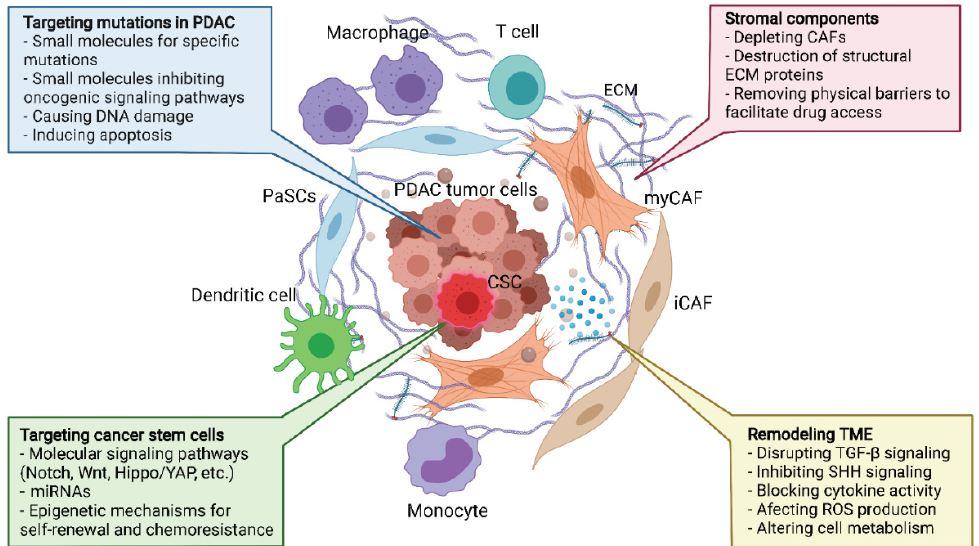
Figure 2. Neoplastic cells and ECM targeting approaches in PDAC treatment. Because of its large contribution to tumor development and treatment resistance, the heterogeneity of tumor cells, mutations, and ECM of PDAC are also attractive targets for therapeutic development. Targeting the KRAS protein and its upstream and downstream signaling are some of the most potential targets for drug development and are under investigation in several trials. Besides that, the therapeutic approaches for eliminating cancer stem cells in PDAC focus on targeting particular major signaling pathways by small molecules or targeting core genetic regulators, such as microRNA, as listed in the boxes. The ECM consists of collagens, fibronectin, and other proteins that can be targeted, together with other therapeutic strategies. PaSC = pancreatic stellate cells, PDAC = pancreatic ductal adenocarcinoma, EMC = extracellular matrix, myCAF = myofibroplastic cancer associated fibroblast, iCAF = inflammatory cancer associated fibroblast. Figure made in